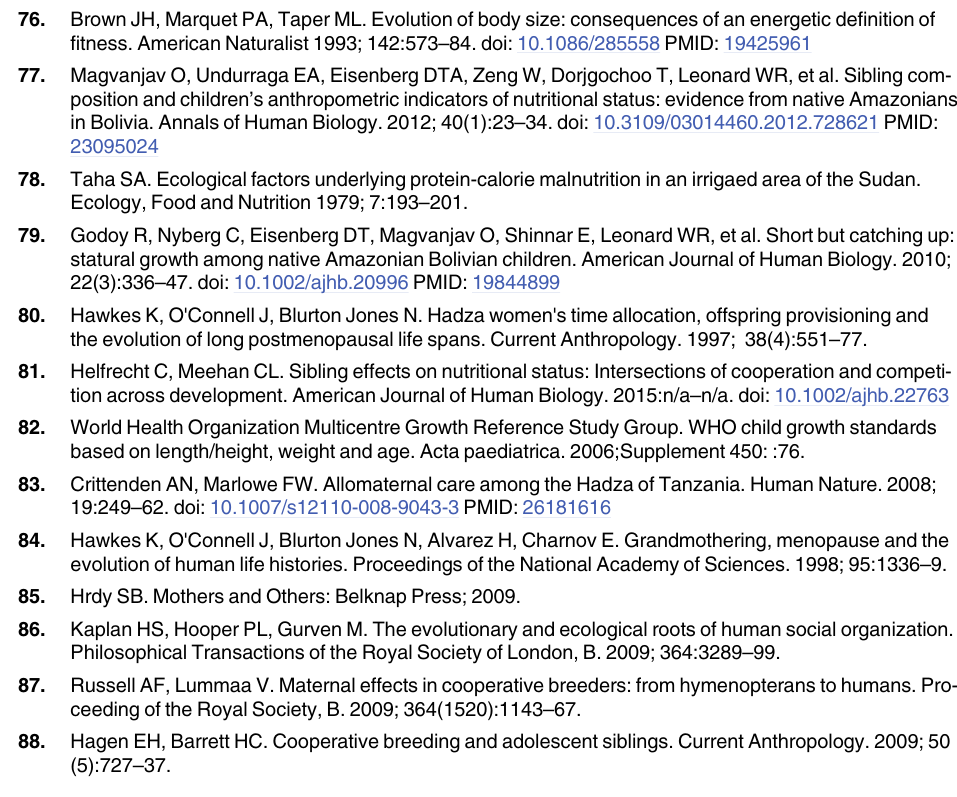
PLOS ONE | DOI:10.1371/journal.pone.0150126 March 3,